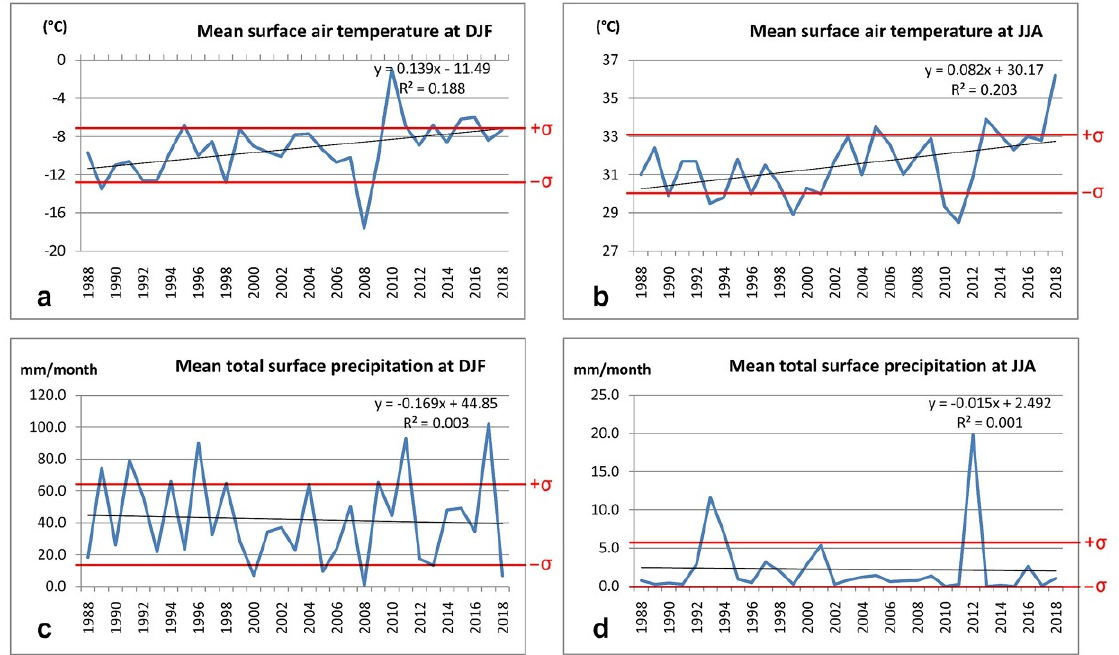
Figure 3. Temporal variations of Iran mean surface air temperature (blue lines) in winter ( a ) and summer ( b ), and Iran mean total surface precipitation (blue lines) in winter ( c ) and summer ( d ) from 1988–2018.The black lines show the trends for each variable during the period of study.